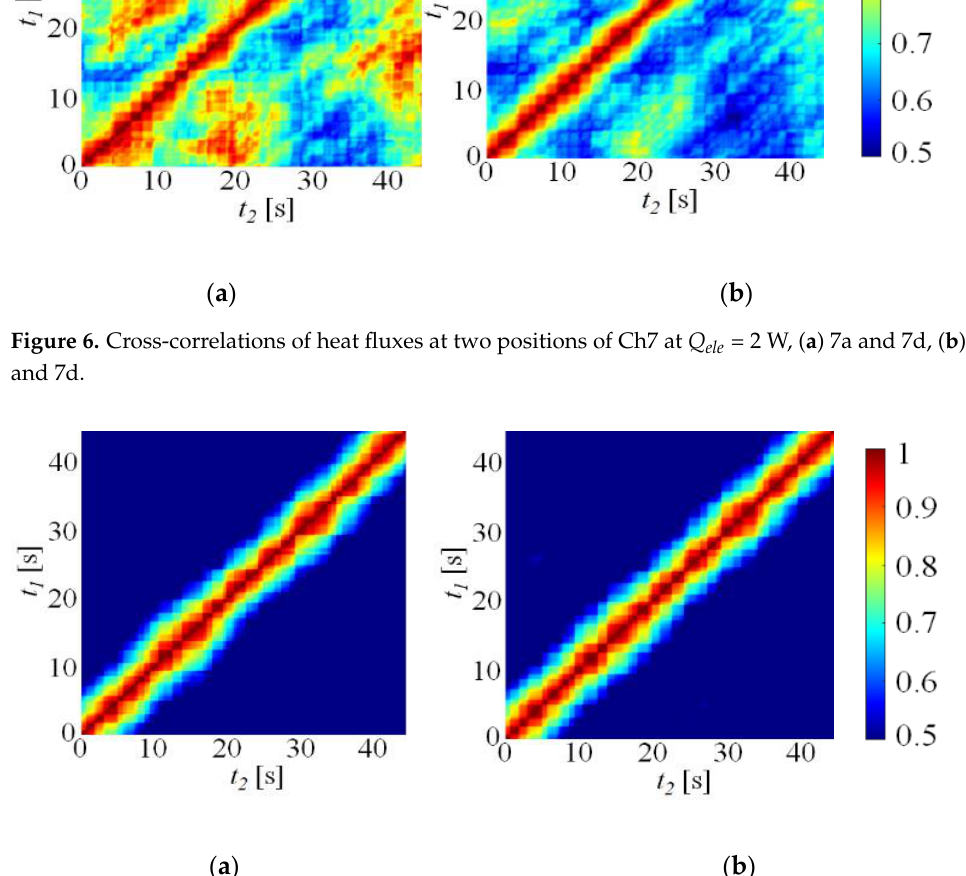
( b ) Figure 8. Cross-correlations of heat fluxes at two positions of Ch1 at Q ele = 2 W, ( a ) 1a and 1d, ( b ) 1c and 1d.